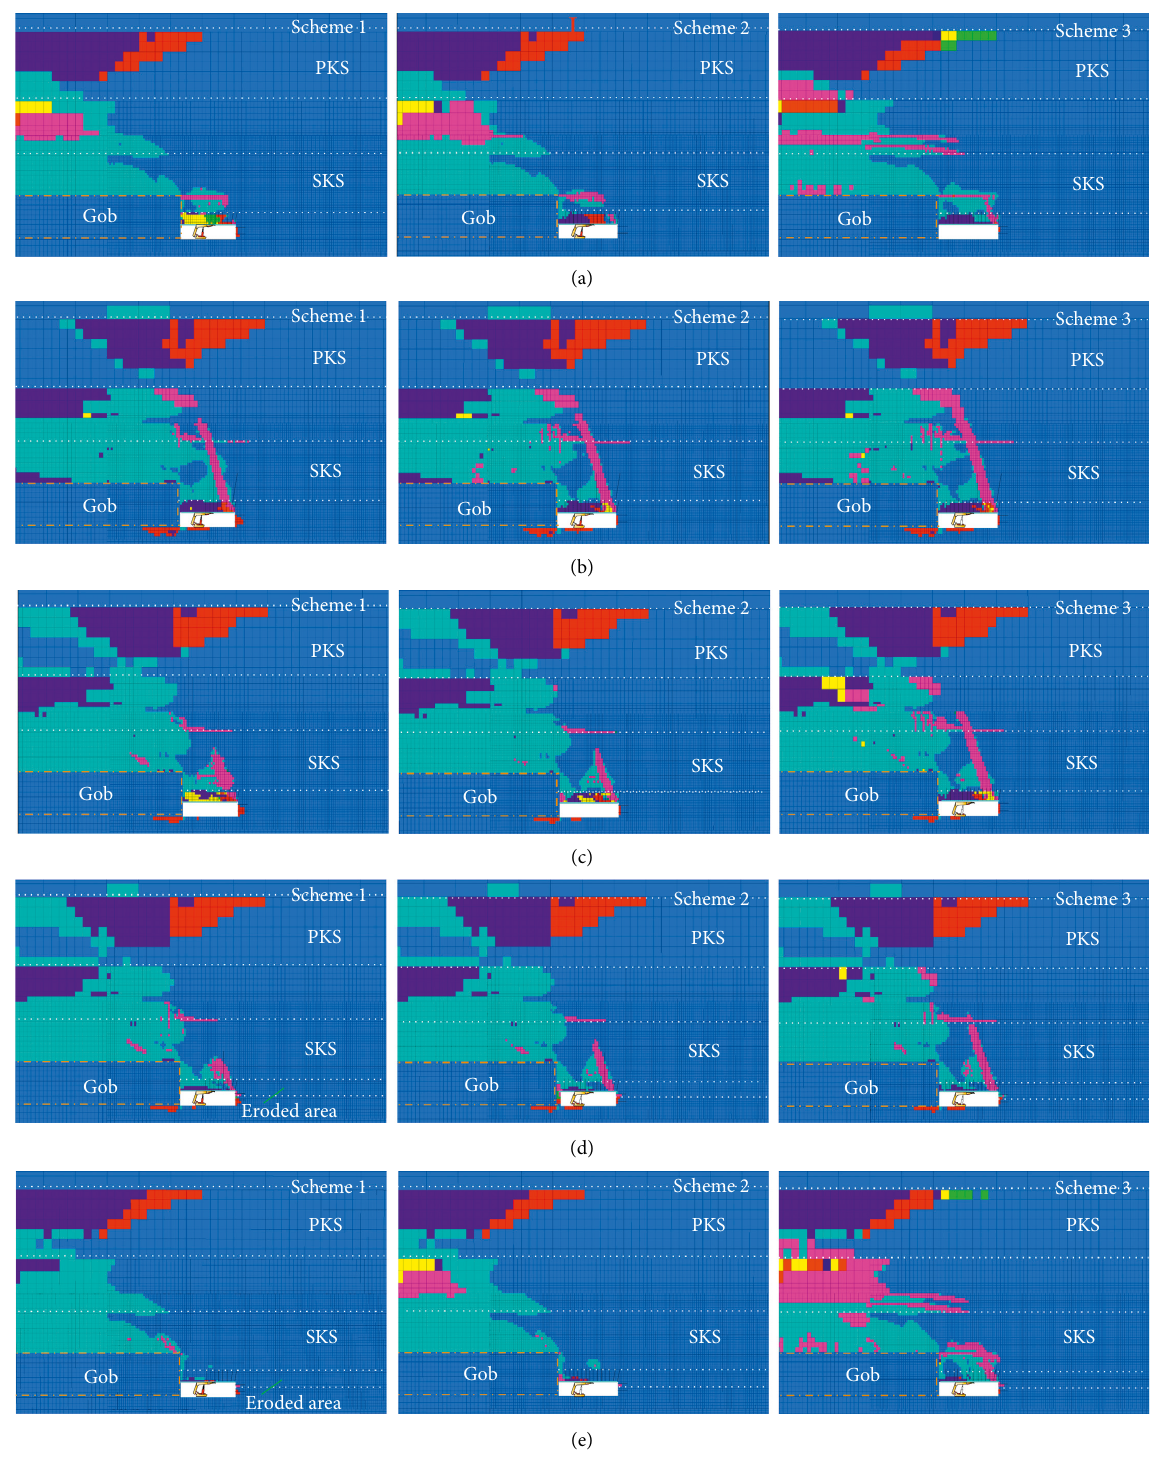
Figure 20: Plastic zone distribution of Stage II. (a) I-I. (b) II-II. (c) III-III. (d) IV-IV. (e)